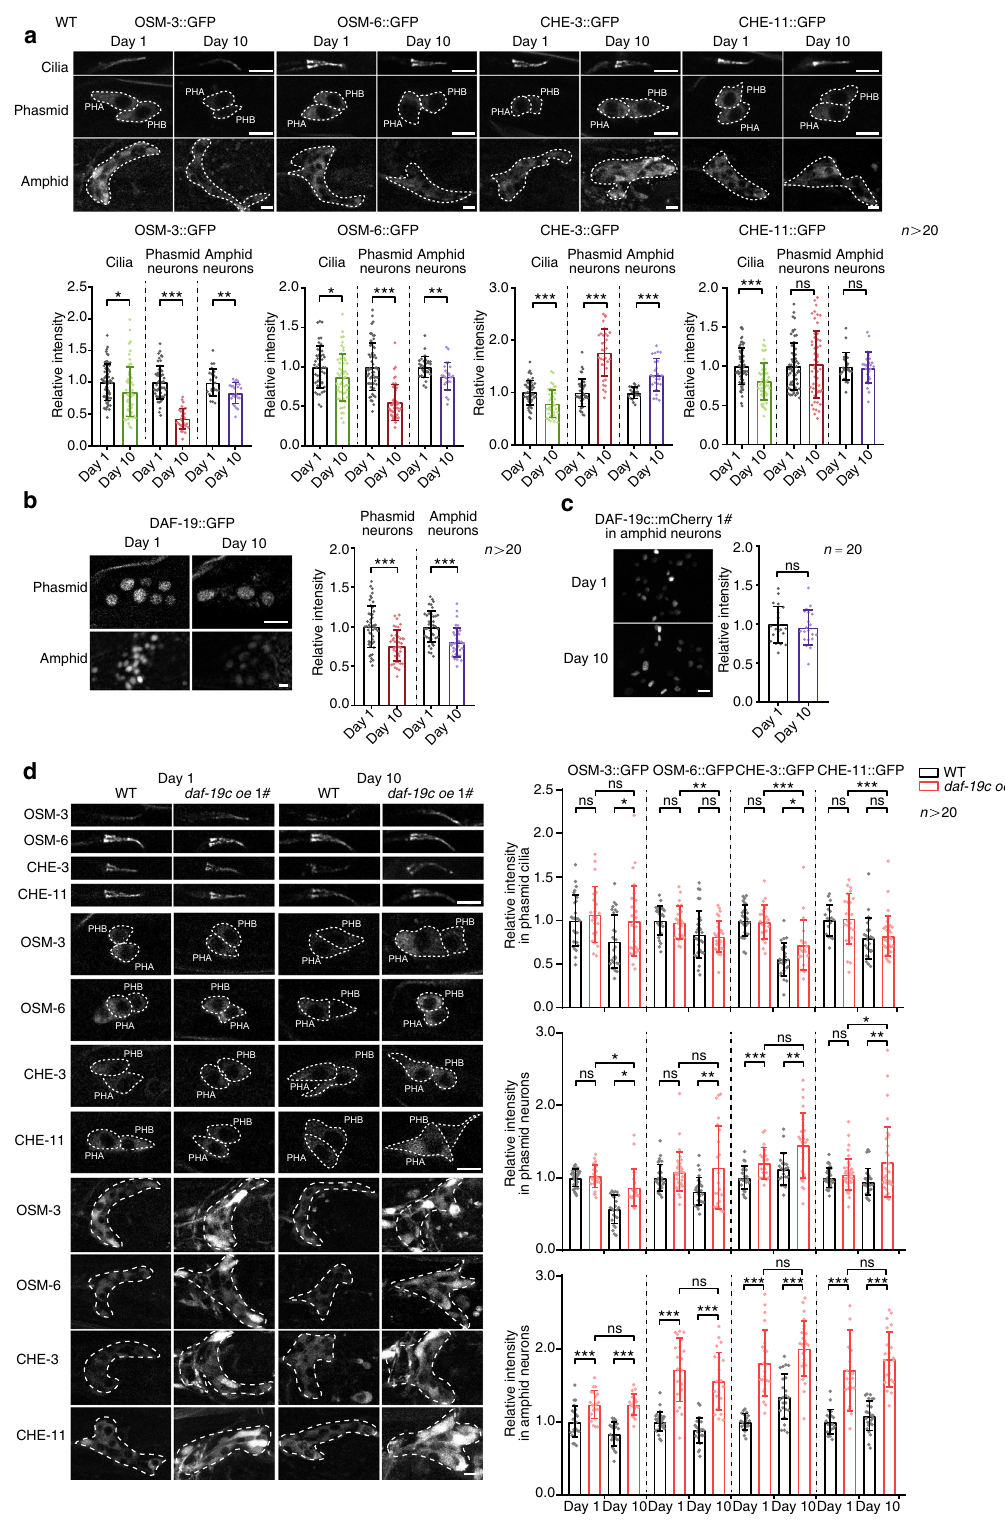
LKB1 in mammalian cilia 29,30 . As daf-19c promotes IFT, overexpressing daf-19c consistently increased PAR-4::GFP loca- lisation in cilia (Fig. 5b). RNAi against par-4 speci fi cally in all neurons or in sensory neurons blocked the increase of p-AMPK in worms overexpressing daf-19c (Fig. 5c and Supplementary Fig. 6a), indicating that sensory cilia control AMPK activity via par-4 . FLCN is required for LKB1 localisation to cilia 31 . Similarly,